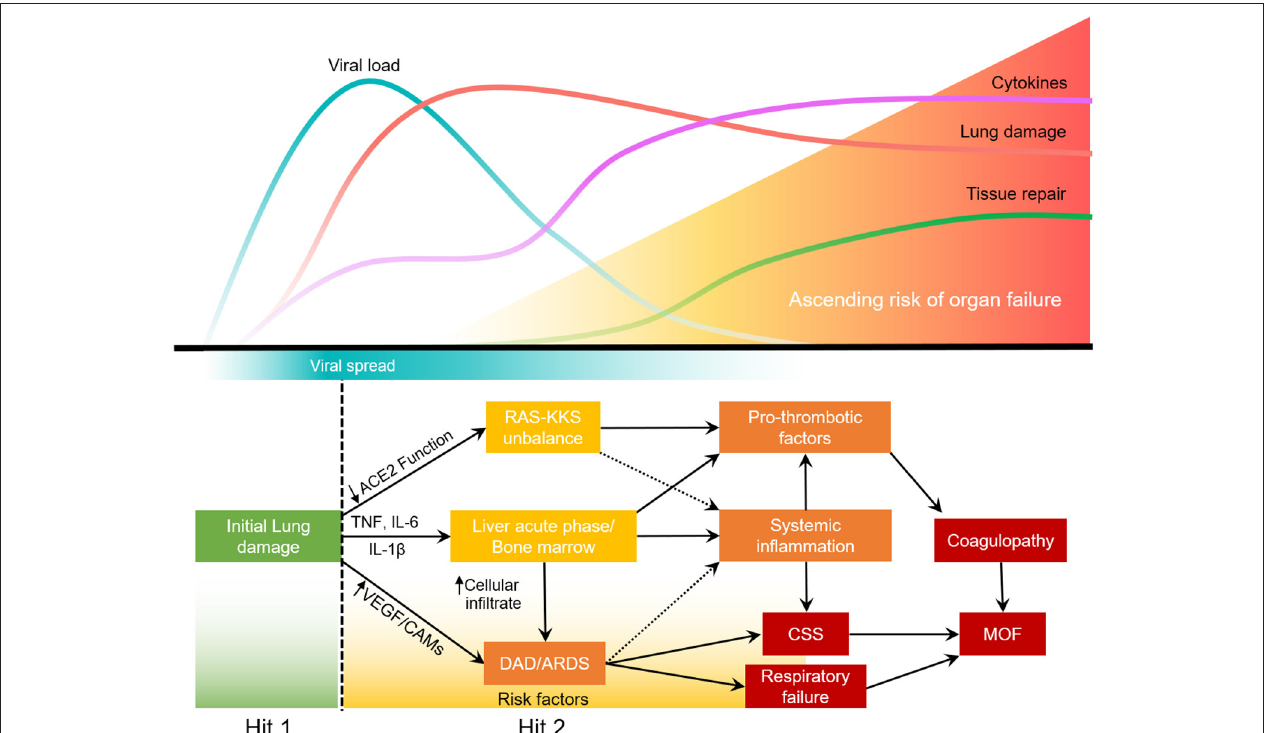
FIGURE 2 | Two-hit model of systemic inflammation derived from COVID-19 associated lung injury.